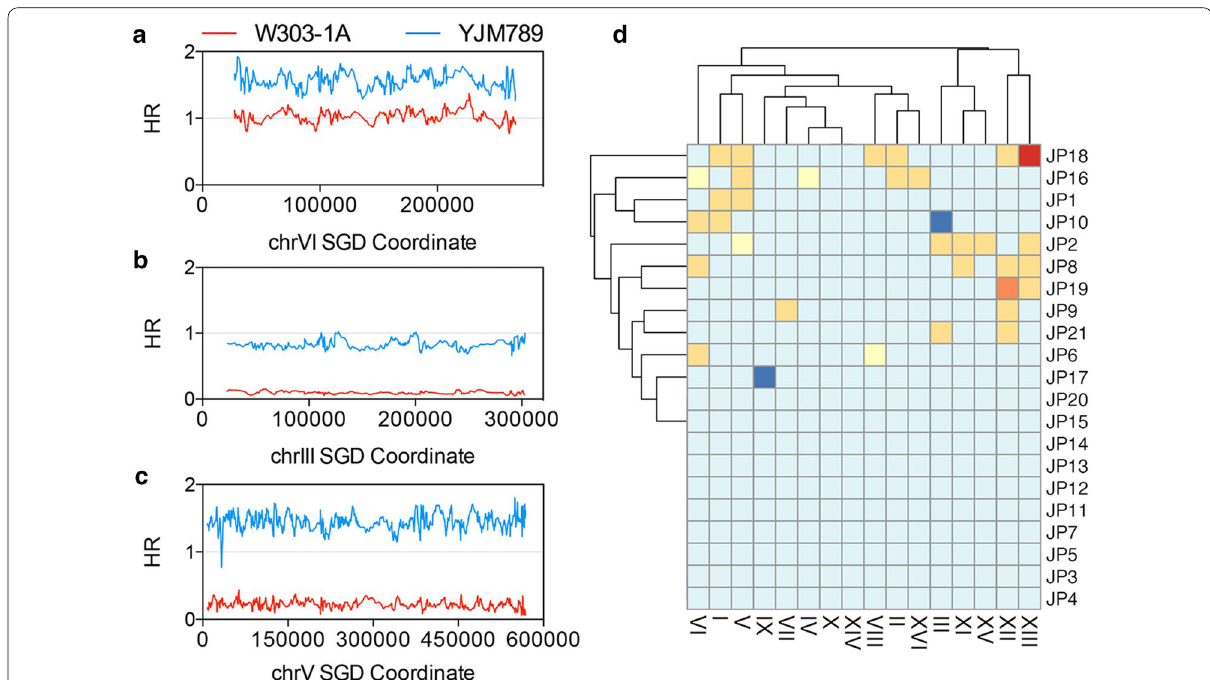
Fig. 4 Aneuploidy events observed in the JSC25‑1‑derived isolates. The SNP results in a – c indicate trisomy, monosomy, and UPD event, respectively. d Heat‑shock‑induced aneuploidy events in the 21 JSC25‑1‑derived isolates. Red, orange, yellow, light yellow, blue, and dark blue represent pentasomy, tetrasomy, trisomy, uniparental disomy, normal, and monosomy,